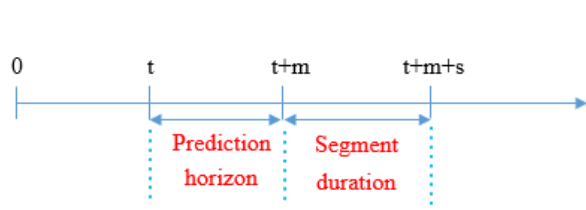
Figure 3. Problem formulation of Viewport